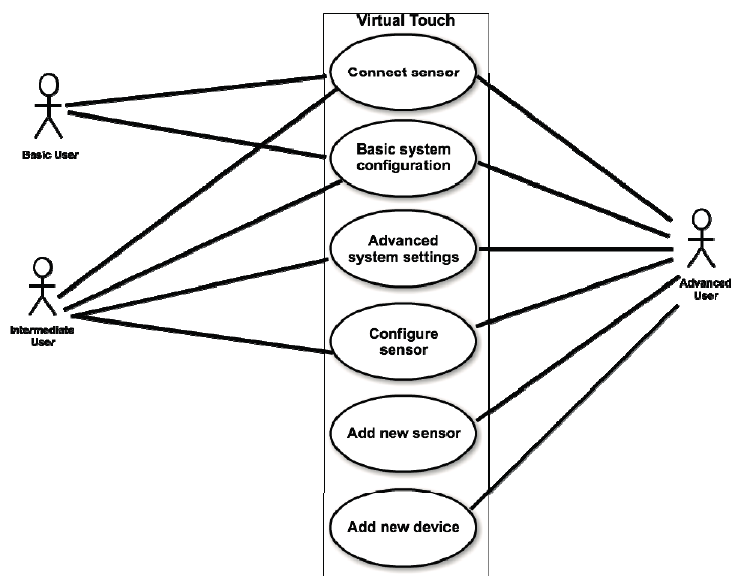
Figure 5. Virtual Touch diagram of use cases.